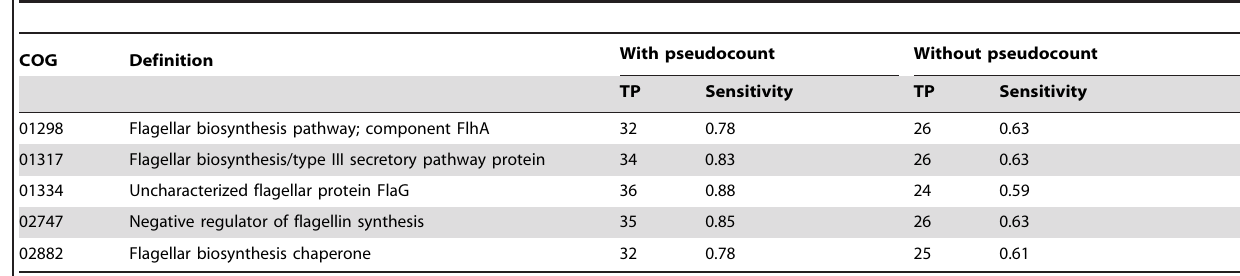
Table 1. Comparison of Psi-sqaure with and without pseudocounts in numbers of true positive (TP) and sensitivity.